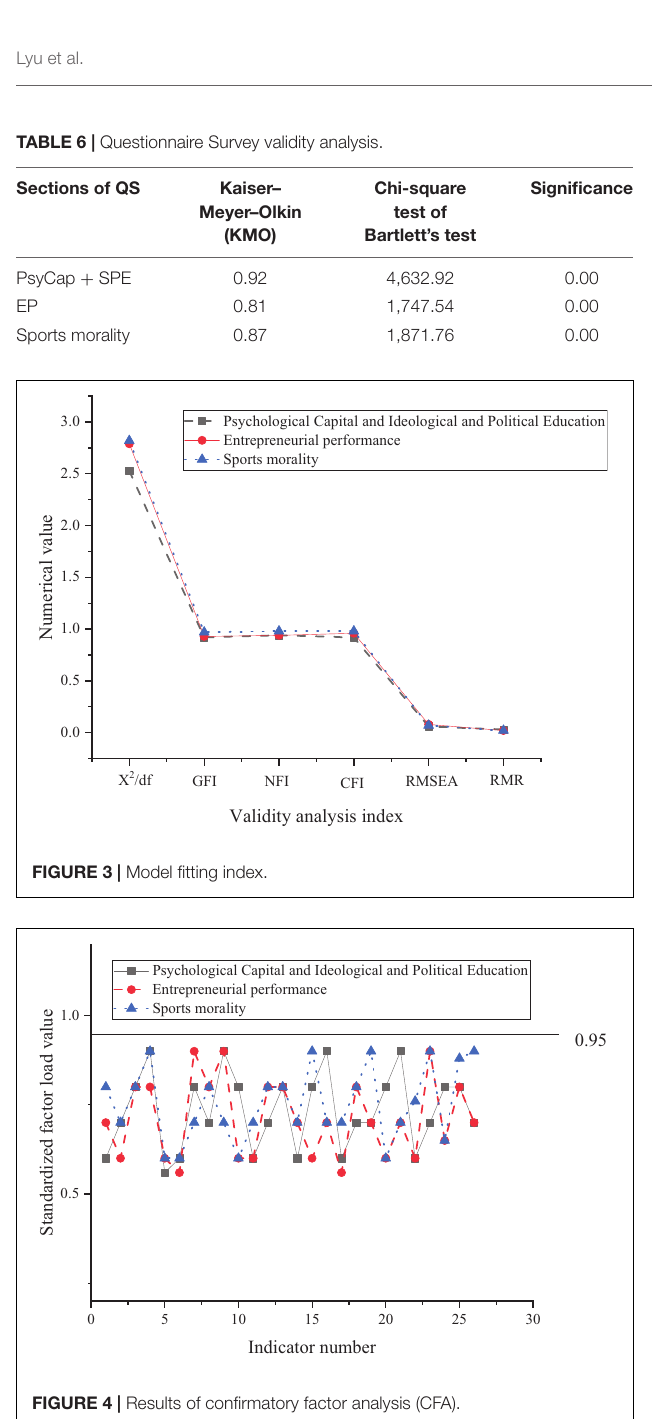
FIGURE 4 | Results of confirmatory factor analysis (CFA).